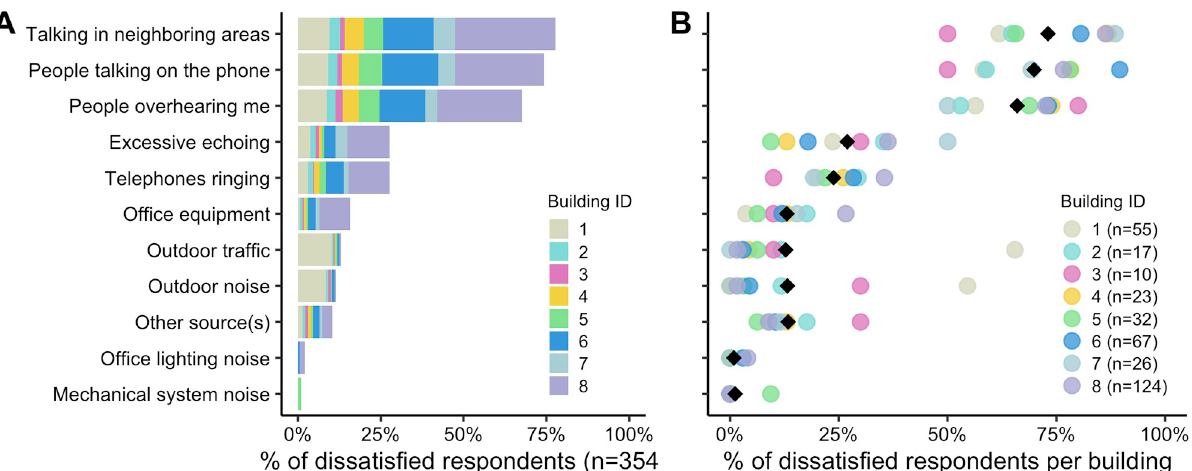
Fig 3. (A) Percentage of dissatisfied occupants across all eight buildings (n = 354) and (B) percentage of dissatisfied occupants per building for each of the 19 potential sources of thermal discomfort (n by building). The black diamond represents the average percent dissatisfied across each of the individual